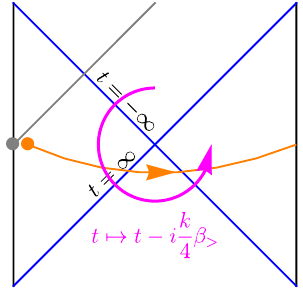
Figure 2 . Moving an operator between spacelike separated boundaries in the analytically extended spacetime. First, we start on the Euclidean sheet of the correlator, such that the operator we want to move (orange dot) is spacelike separated from the rest of the insertions (gray dot). Then we move the operator from one side to the other in the analytically extended Lorentzian spacetime, and we can do this without crossing light cones. In terms of Killing time coordinate t , this amounts to sending t 7! (cid:6) i(cid:12) > = 2 in the position of the operator (wile keeping a co-rotating coordinate (cid:12)xed, if this is a rotating black